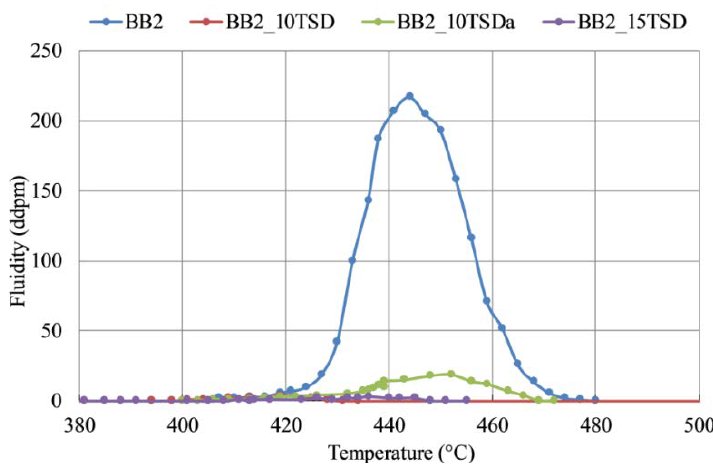
Figure 4. Gieseler test result for the blends carbonized in technical scale, average of two tests.